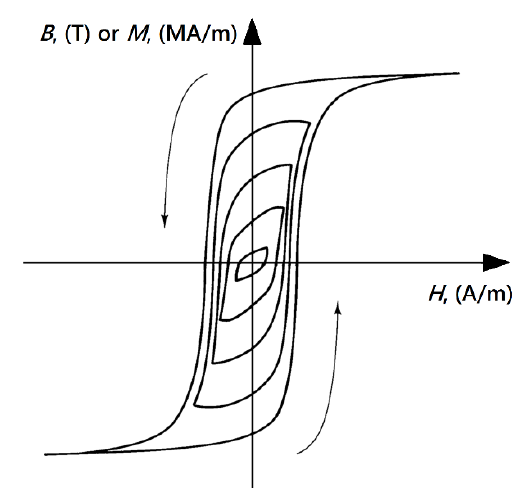
Figure 1. A family of hysteresis loops for a soft ferromagnetic material. The largest loop, exhibiting saturation, is referred to as the major loop.